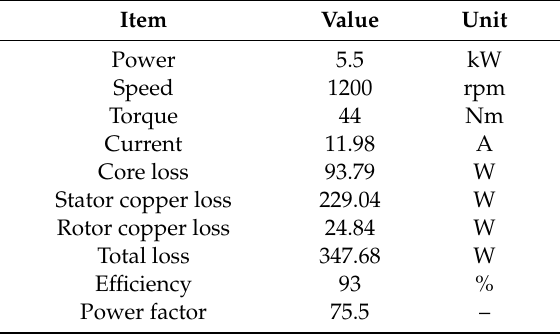
Figure 13. The final model of LS-PMA-SynRM: ( a ) FEA model, ( b ) magnetic flux density. Table 5. FEA result of LS-PMA-SynRM.